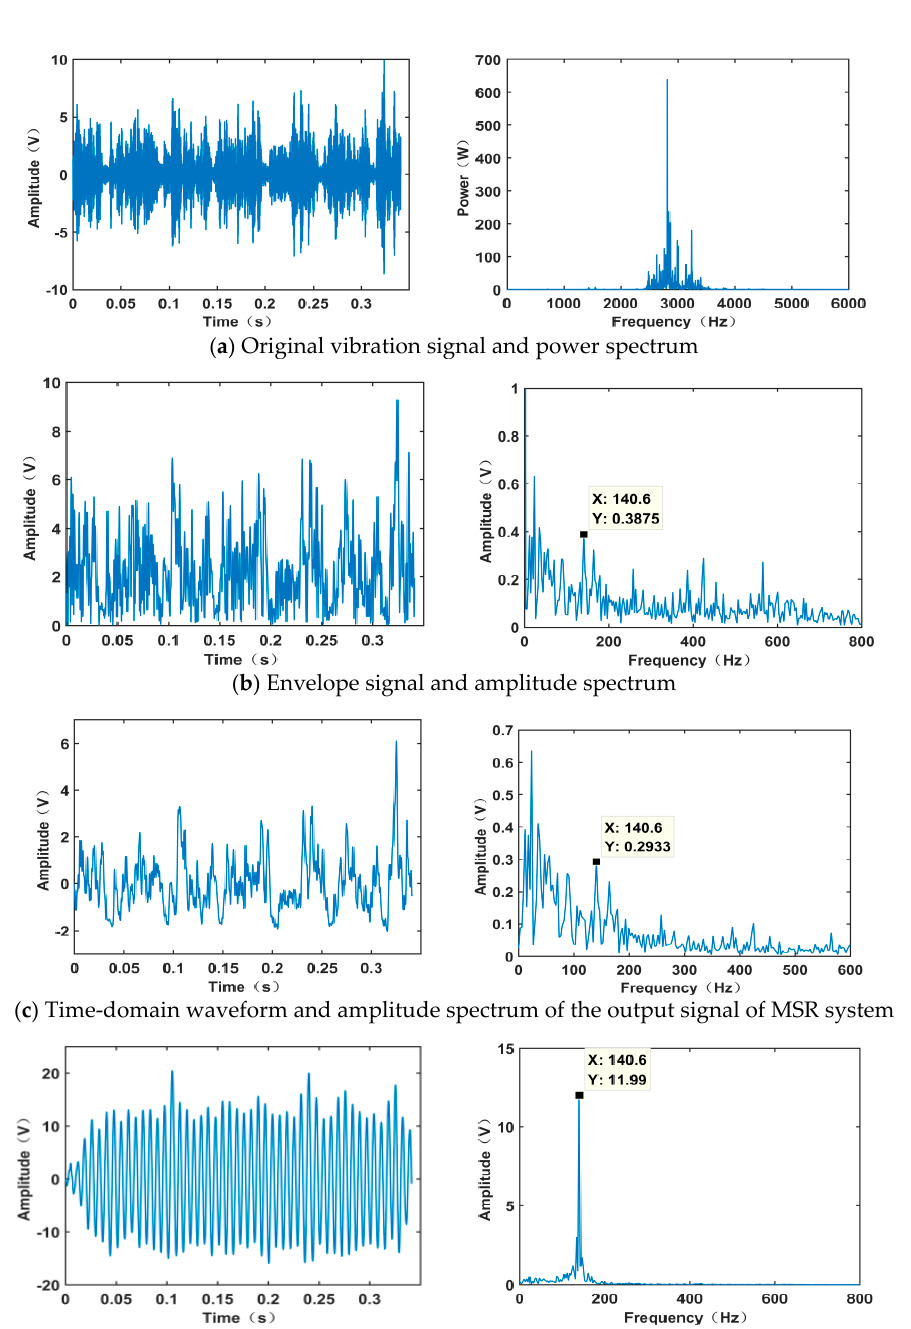
Figure 8. Inner race failure analysis.